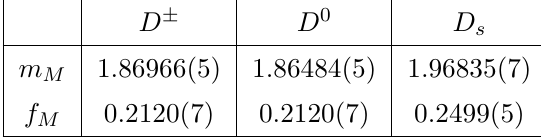
Table 16. Masses and decay constants of D mesons in GeV, from the latest PDG [21] and FLAG [104, 157, 158] values. Uncertainties in the final digit(s), which are neglected in this study as they are dominated by other effects, are given in brackets.